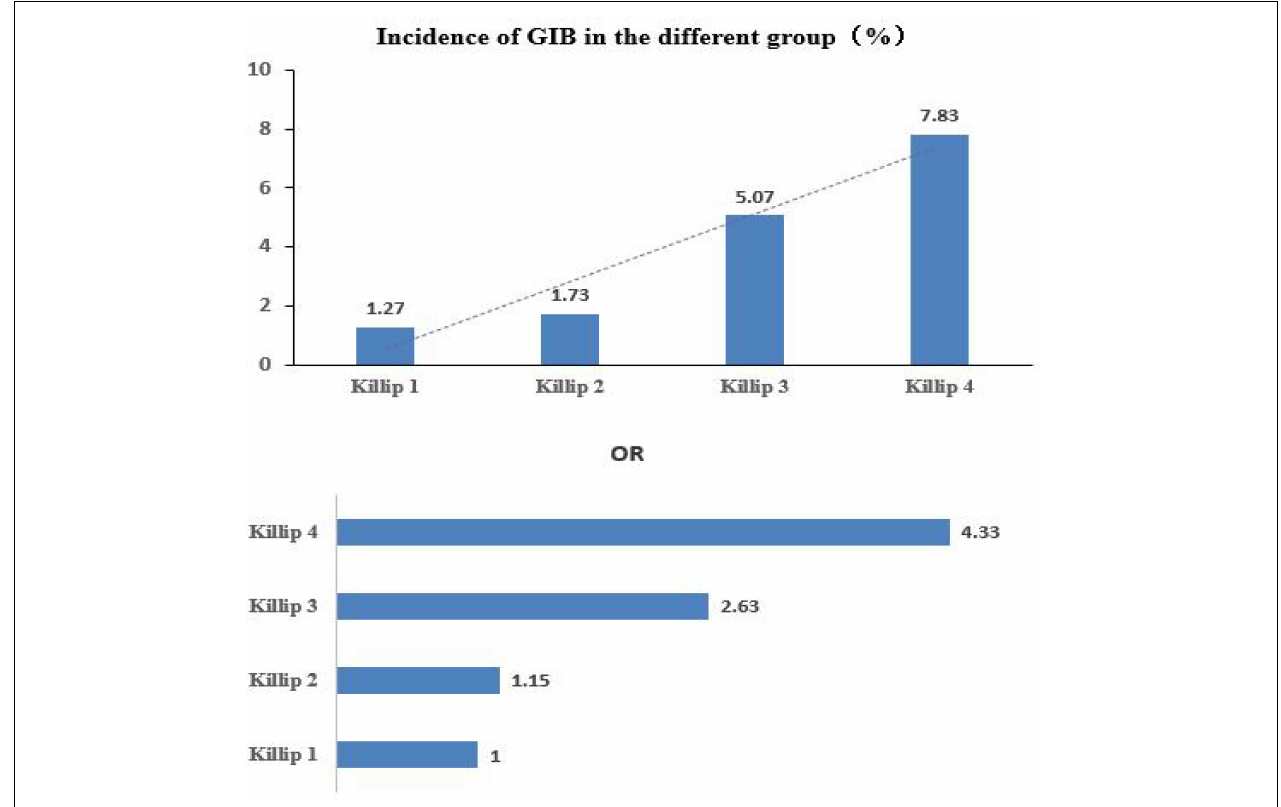
FIGURE 2 | Higher Killip classes are associated with an increased risk of developing gastrointestinal